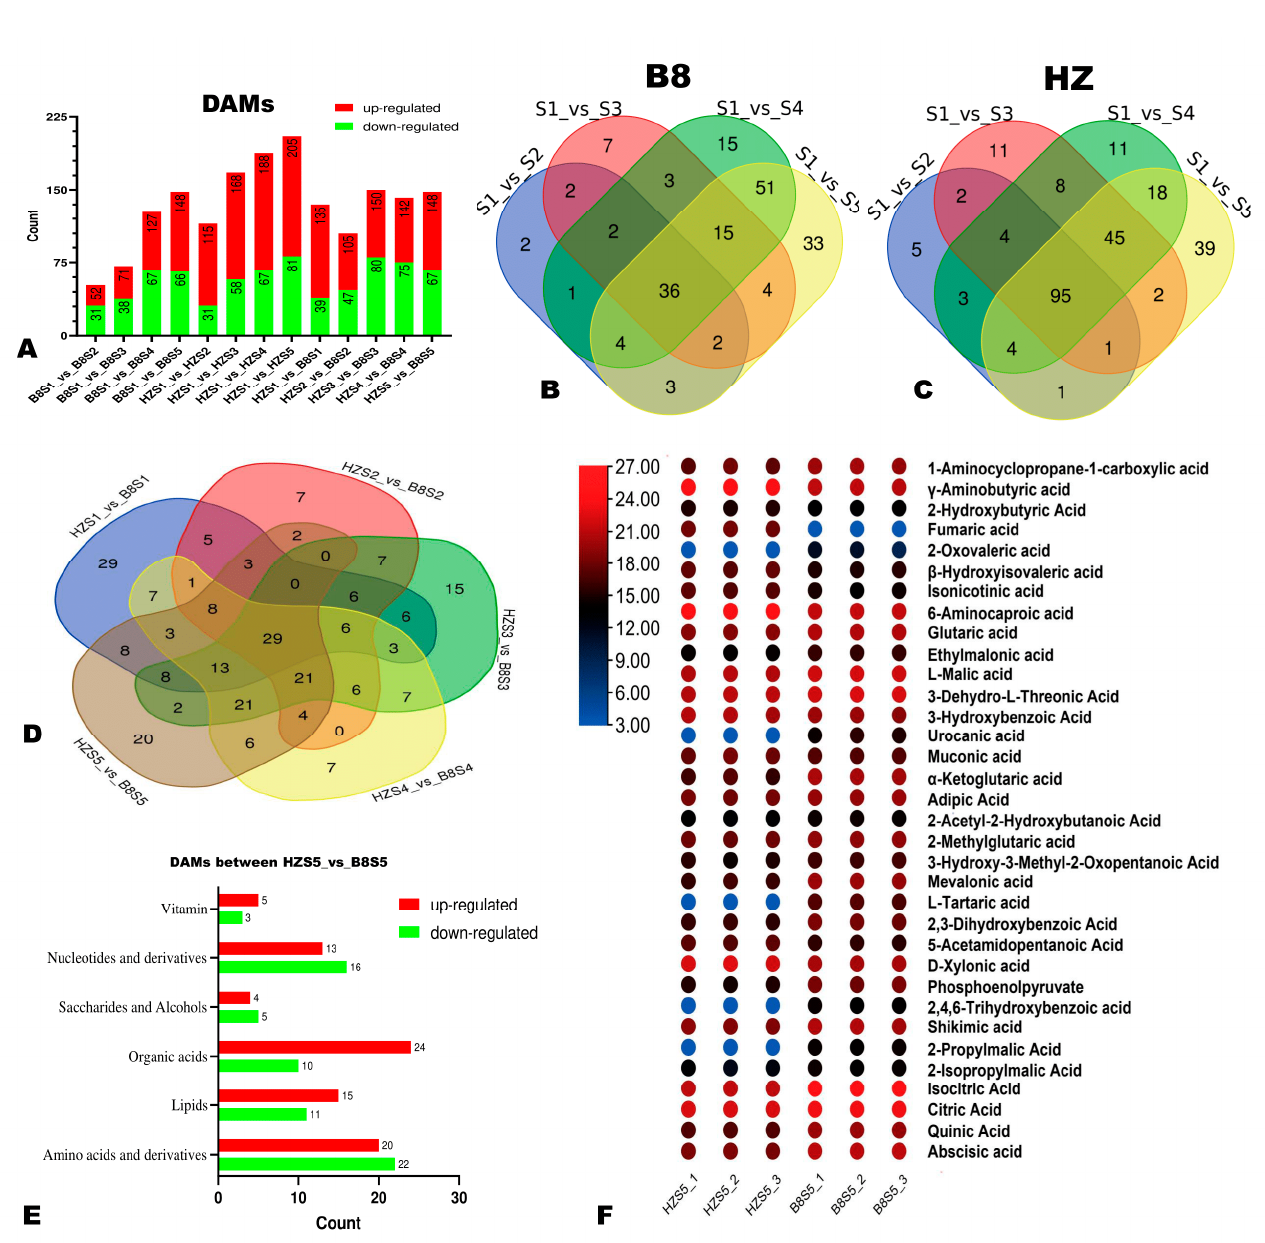
Figure 4. Differentially accumulated metabolites (DAMs) between HZ and B8 during fruit ripening. ( A ) Summary of the number of DAMs during fruit development in B8 and HZ and between the two varieties. ( B , C ) Venn diagram showing the number of DAMs in B8 and HZ along with fruit development, respectively. ( D ) Venn diagram of the DAMs between HZ and B8 at the five fruit developmental stages. ( E ) Classification of the 148 DAMs between HZ and B8 at the red ripening stage (S5). ( F ) Heatmap of relative content of differentially accumulated organic acids between HZ and B8 at S5.